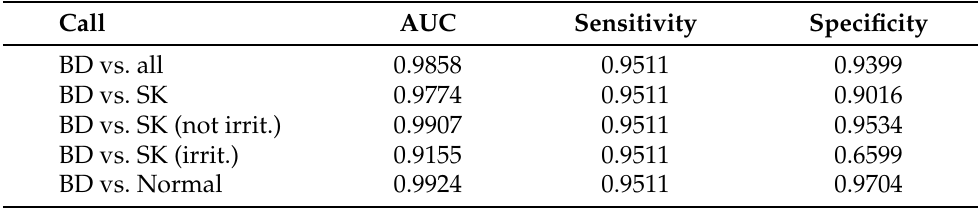
Table 5. Test scores for the different calls on the test set from Center 0.